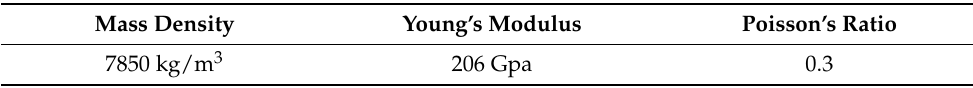
Table 1. Main parameters of the structure in finite element calculation.